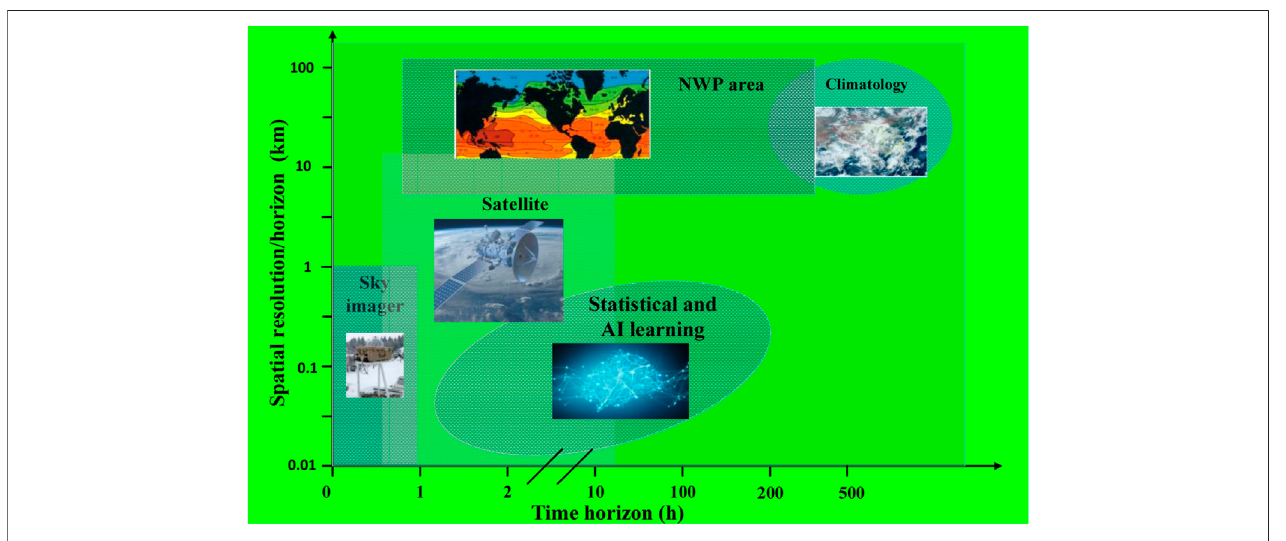
FIGURE 1 | Prediction algorithm and its corresponding time/space